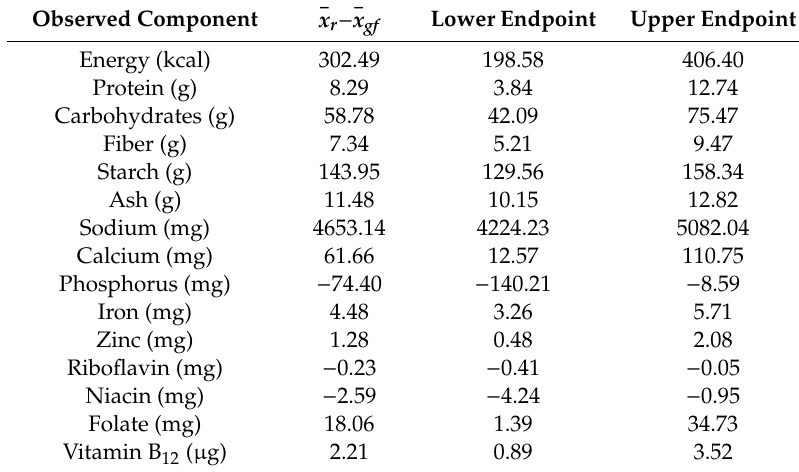
Table 3. Lower and upper endpoints of a 95% confidence interval for the di ff erence between mean regular and gluten-free diet.